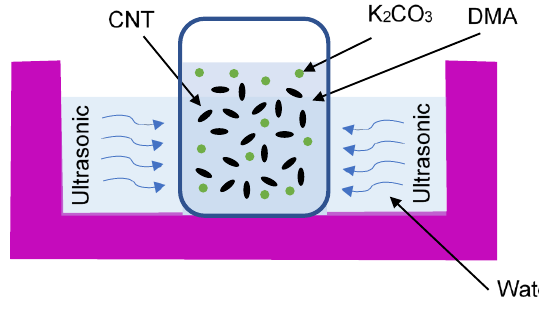
Figure 1. Schematic illustration of dispersion processes for CNT.